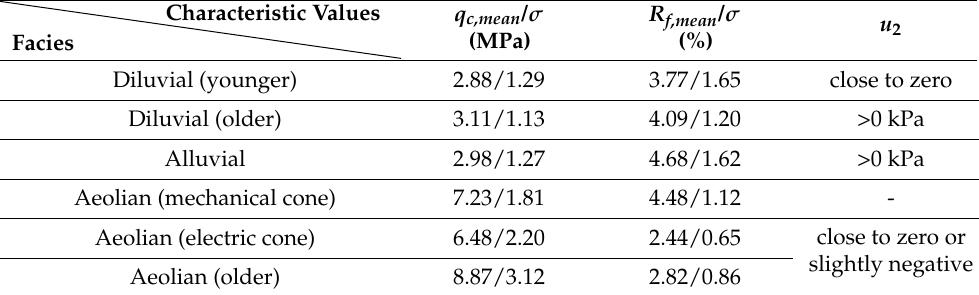
Table 2. Characteristic values of CPTU parameters for loess facies.